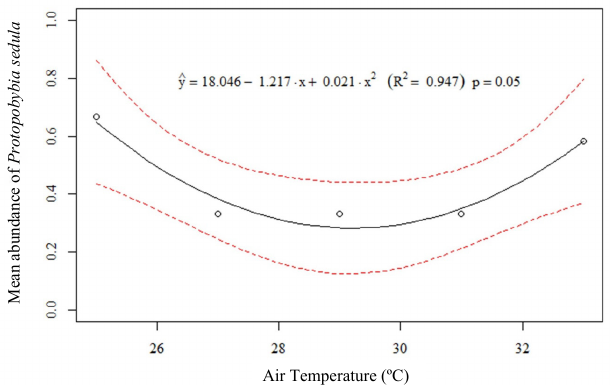
Fig 5 . Effect of air temperature on average number of wasps of Protopobybia sedula (Hymenoptera: Vespidae) species foraging in kale plants ( Brassica oleraceae var. acephala ) from July to November 2016 in Bambuí, MG. Table 2 . Temporal niche overlap (Schoener index) among pairs of species of social wasp (species with more than eight individuals) collected in kale ( Brassica oleracea var. acephala ) crops at the Federal Institute of Education, Science and Technology of Minas Gerais (IFMG), Bambuí Campus , Minas Gerais. Significance (P≤0.05) for the Kolmogorov-Smirnov test for two samples used to evaluate differences between the patterns of temporal activity among pairs of species of social wasps is indicated above the